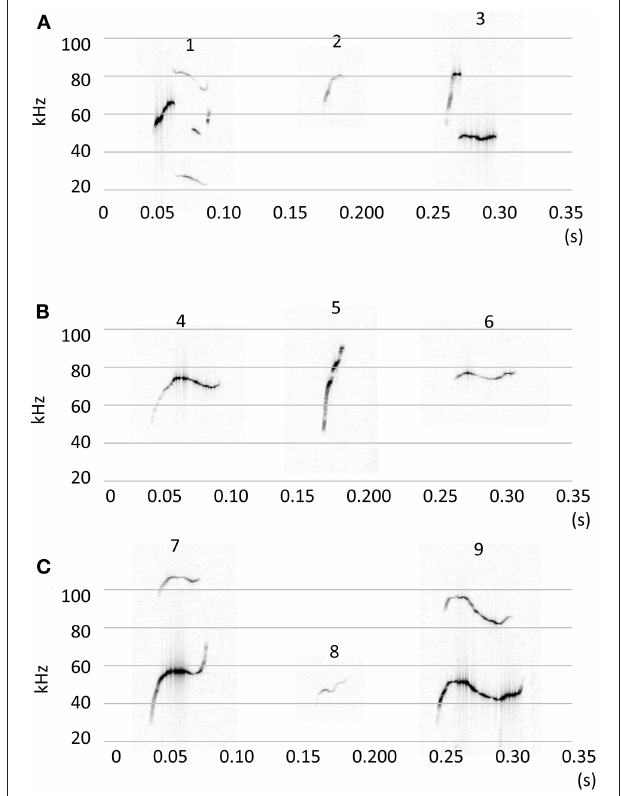
FIGURE 3 | Representative figures of 9 call types (A) Call type 1–3. (B) Call type 4–6. (C) Call type 7–9. Calls were classified using 12 acoustic parameters by the k-mean clustering